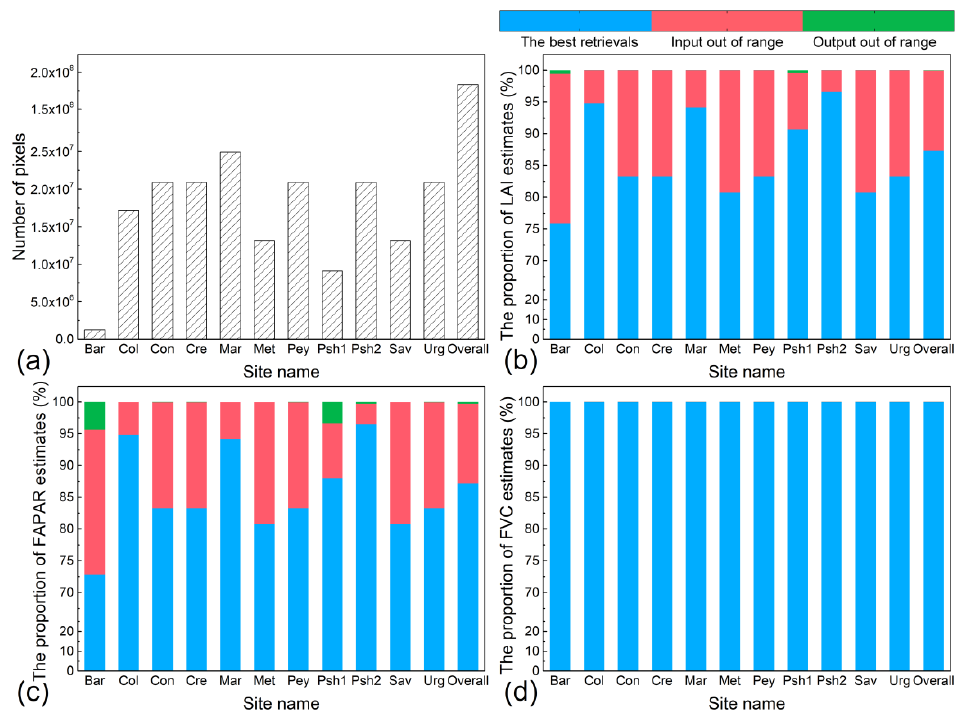
Figure 5. ( a ) The number of pixels used in evaluating the spatial coverage of retrievals from different algorithm paths for Sentinel-2 biophysical estimates at each site. The pixel identified as vegetation in the scene classification layer was selected. The proportion of ( b ) LAI, ( c ) FAPAR, and ( d ) FVC estimates with the best retrievals, input out of range, and output out of range in all vegetation pixels at each site was also displayed. The “Bar”, “Col”, ”Con”, “Cre”, “Mar”, “Pey”, “Psh1”, “Psh2”, “Sav”, and “Urg” are the abbreviation name of Barrax, Collelongo, Creón D'armagnac, Maragua_UpperTana, Peyrousse, Pshenichne (2015-188), Pshenichne (2015-204), Savenès, and Urgons sites.